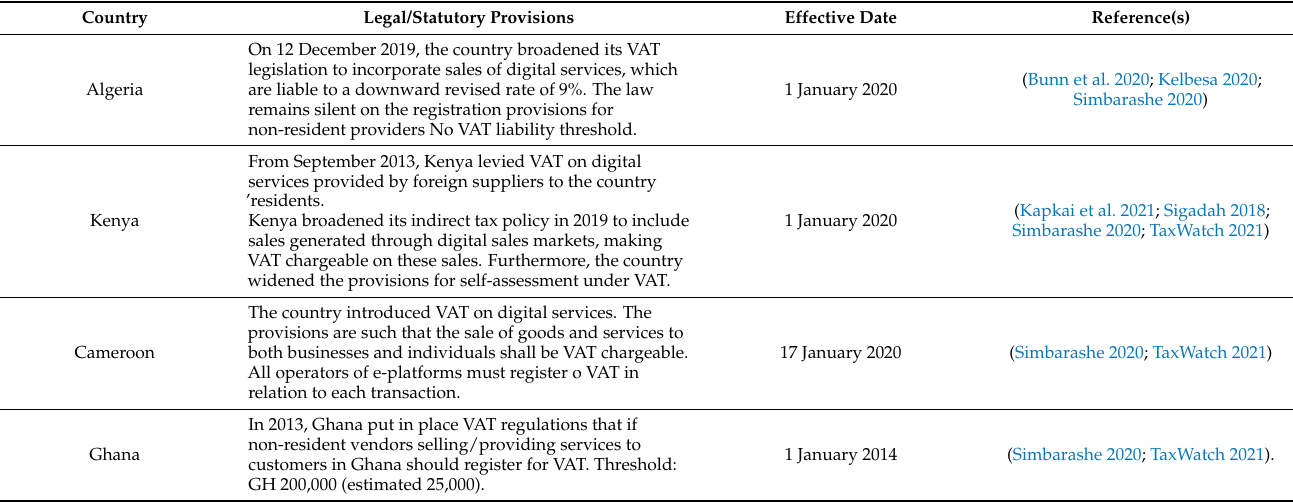
Table 1. Summary of VAT regulations in selected African